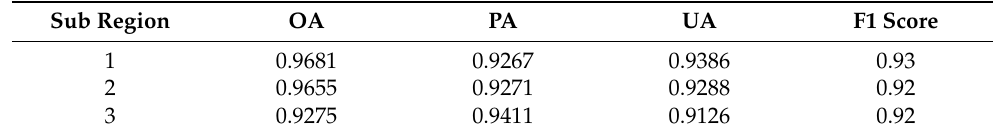
Table 6. Accuracy evaluation of BA extraction results in three sub